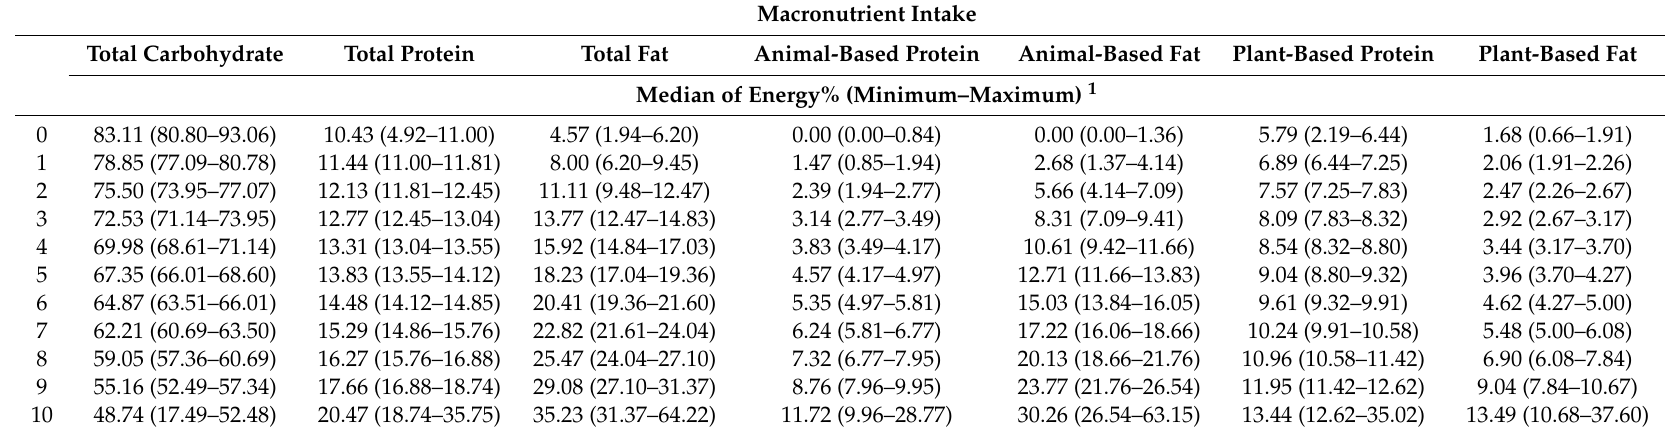
Table 1. Energy percent of macronutrients used in calculating the low-carbohydrate diet (LCD) scores, animal-based LCD scores, and plant-based LCD scores of Chinese adults, China Health and Nutrition